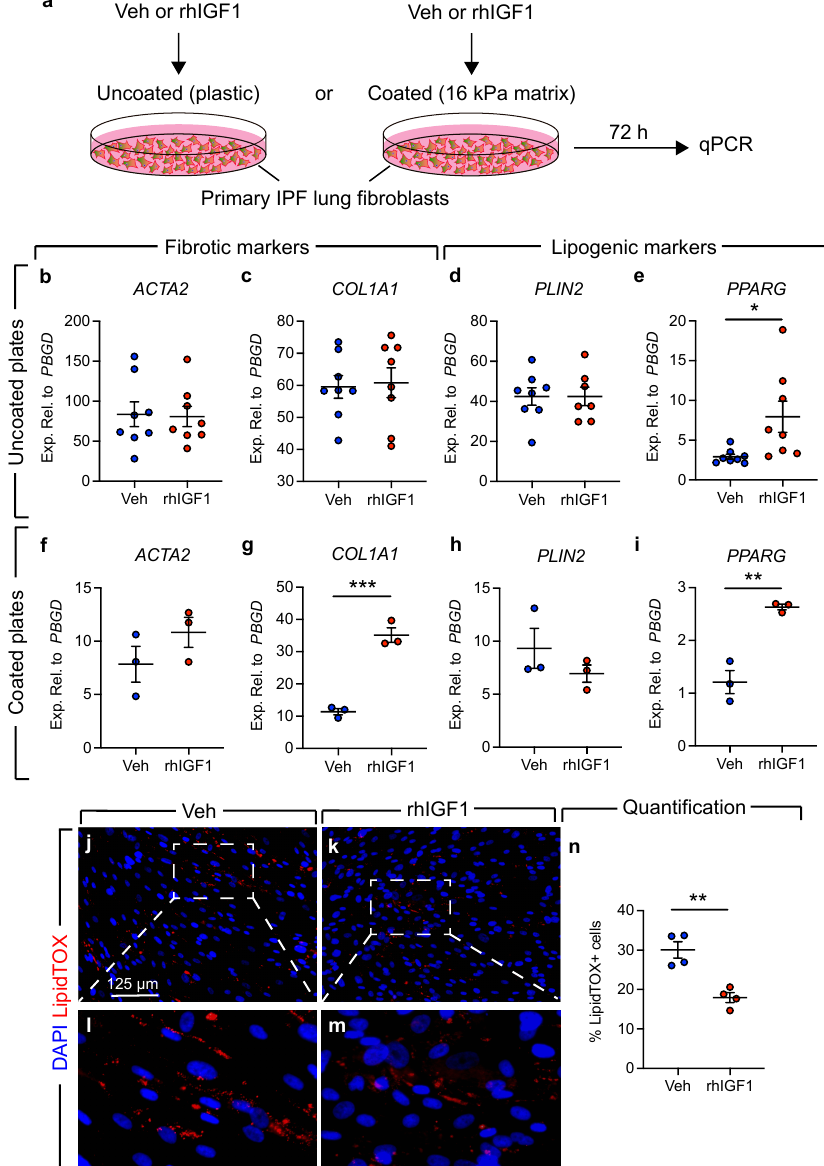
Figure 4. Effect of recombinant IGF1 treatment on primary human lung fibroblasts. ( a ) Scheme for experimental design. ( b – e ) qPCR on primary IPF lung fibroblasts cultured on uncoated plates and treated with vehicle or recombinant human IGF1. ( f – i ) Similar analysis using coated plates. ( j – m ) Neutral lipid stain on primary IPF lung fibroblasts cultured on uncoated plates. Nuclei are stained with DAPI. ( n ) Quantification of LipidTOX staining. rhIGF1: Recombinant human IGF1; Veh: Vehicle. t-test was used to compare the means. ( b – e ) Veh: n = 8, rhIGF1: n = 7–8; ( f – i ) n = 3 per group; ( n ) n = 4 per group. * p < 0.05, ** p < 0.01, *** p <